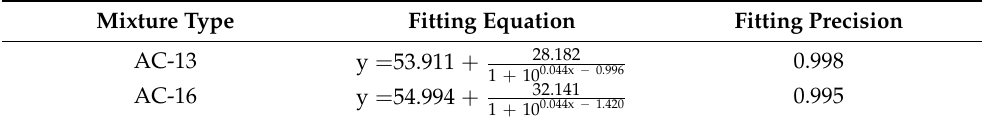
Table 2. Fitting curve of BPN value change under different aeolian sand